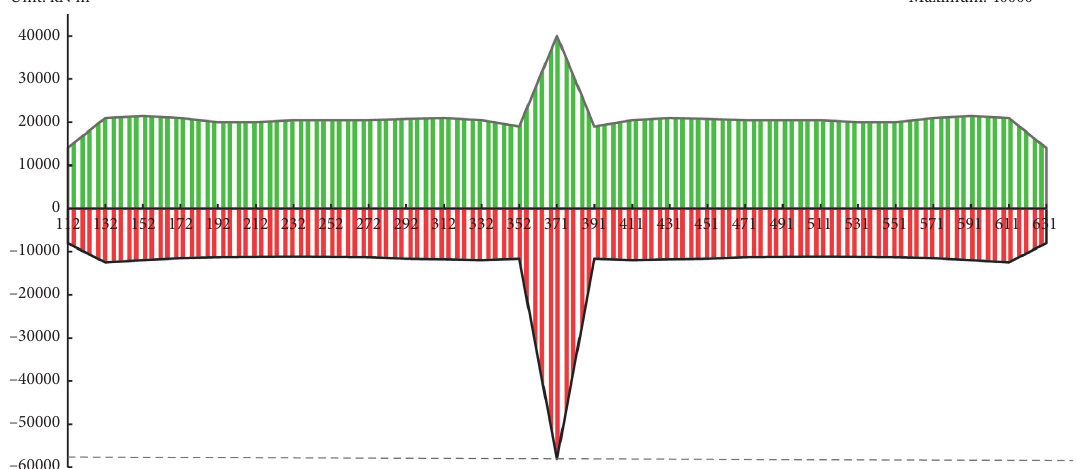
Figure 5: Bending moment envelope diagram of the girder under random traffic flow